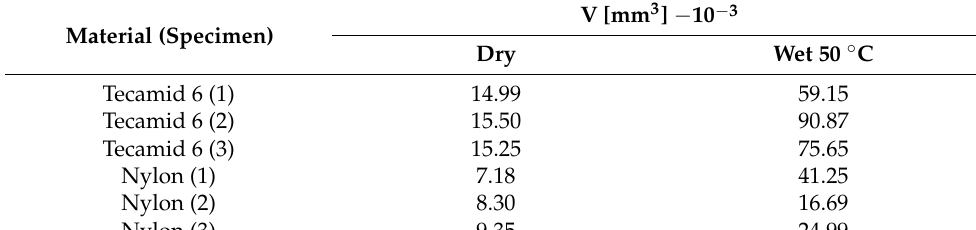
Figure 9. Comparison of friction coefficient results depending on the number of friction cycles and materials tested: ( a ) dry test; ( b ) wet test 50.